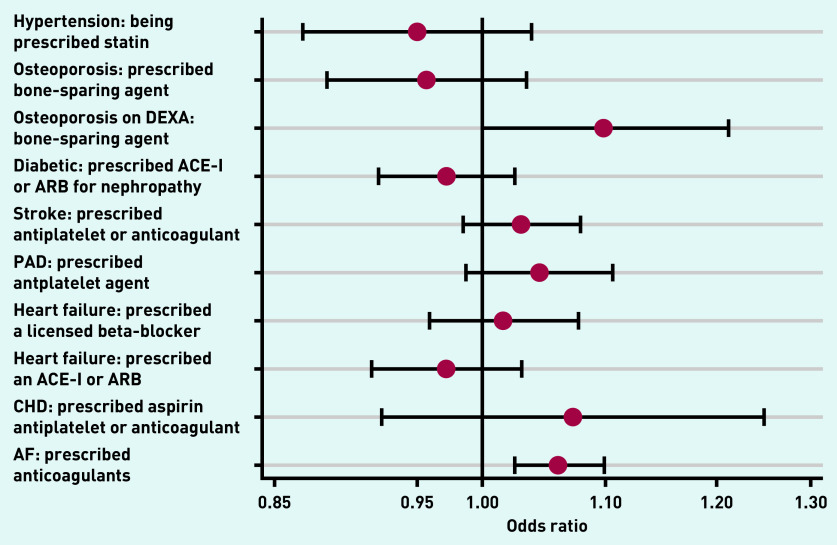
Differences between dispensing and non-dispensing practices in outcomes dependent on prescription but not adherence.ACE-I = angiotensin-converting enzyme inhibitor. AF = atrial fibrillation. ARB = angiotensin receptor blocker. CHD = coronary heart disease. DEXA = dual energy X-ray absorptiometry. PAD = peripheral arterial disease.